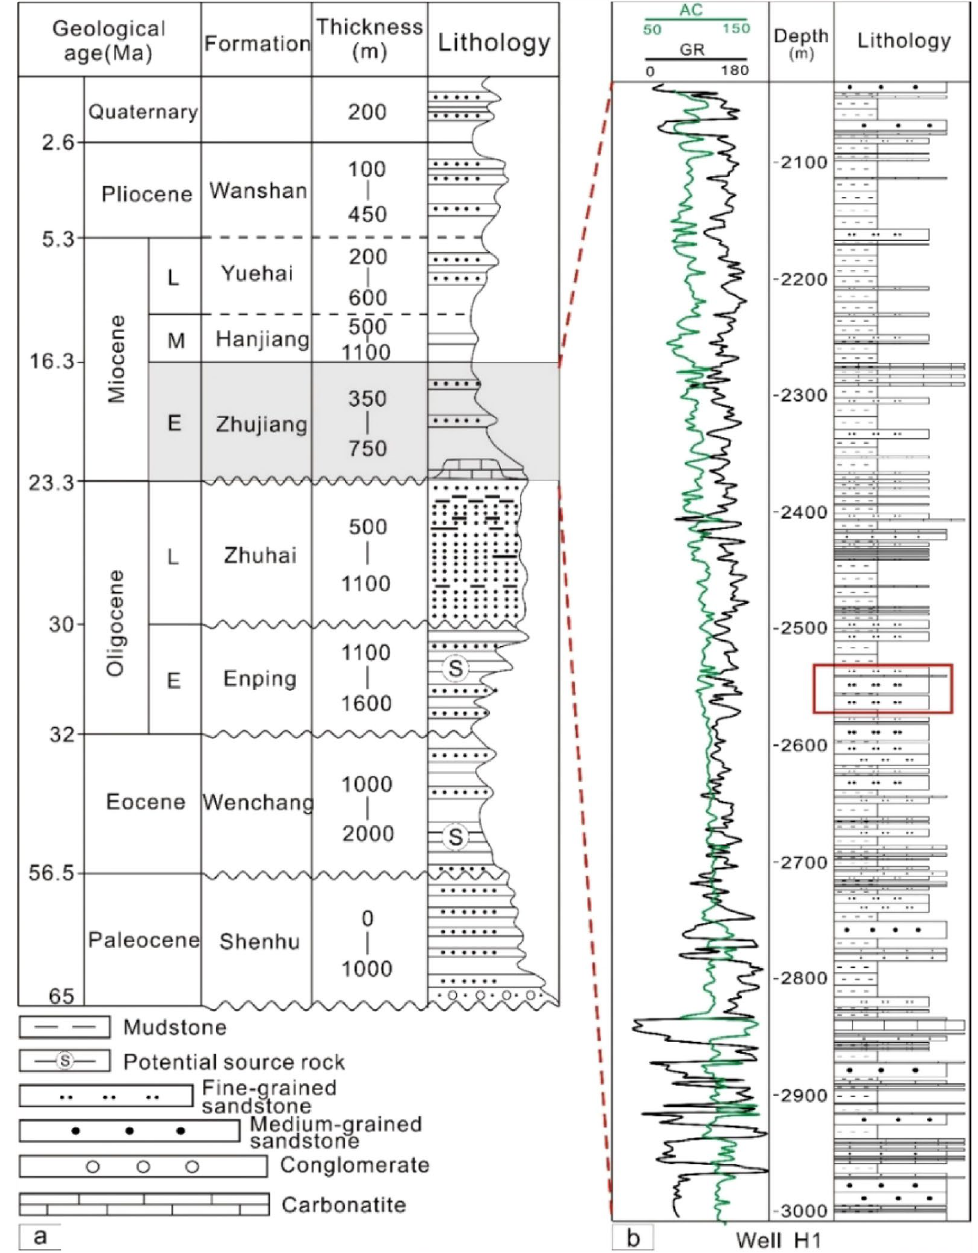
sets of potential source rocks in Enping and Wenchang Formations in terms of thickness and continuity. ( b ) Detailed stratigraphic column of well H1. Varying vertical lithofacies imply strong depositional heterogeneity for the reservoirs. The K22 layer is shown in the red box 14